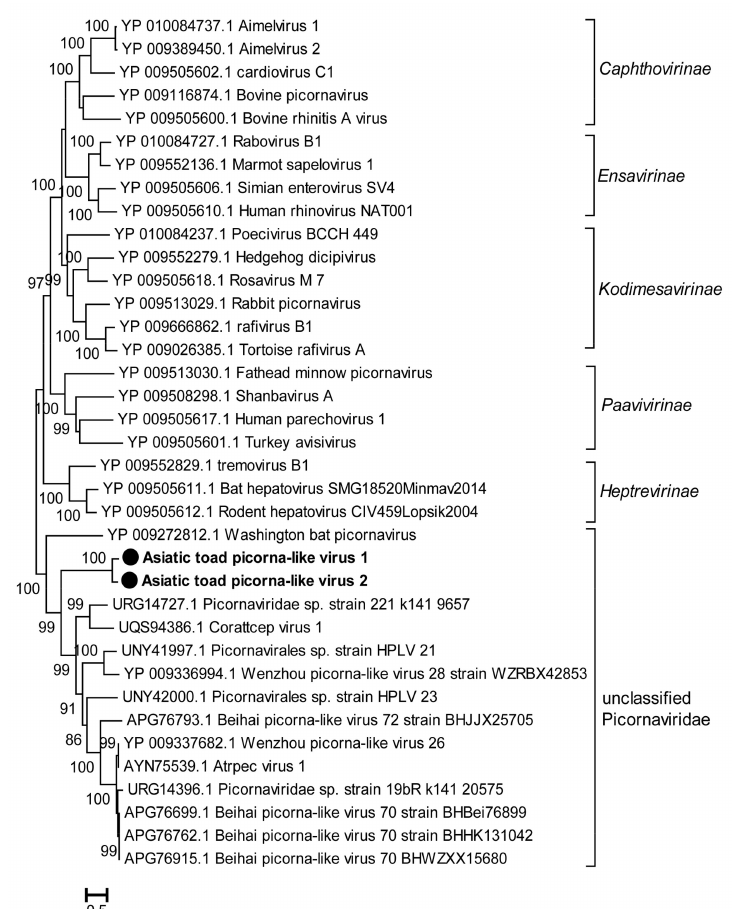
Figure 6. Phylogenetic analysis based on the amino acid sequence of the RdRp of picornaviruses. The phylogenetic tree was constructed using the Maximum Likelihood method in PhyML with 1000 bootstrap replicates. The novel strains identified in this study are marked with black solid circles and indicated by bold text. Percent bootstrap support is indicated by the value at each node. Taxonomy information is reported on the right of each